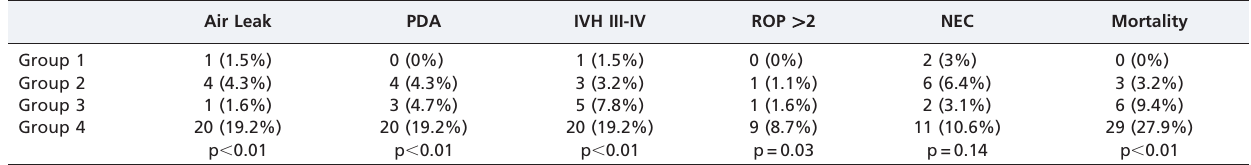
Table 3 - The incidence of adverse outcomes in the different airway-management groups. The need for prolonged mechanical ventilation was associated with significantly higher rates of interstitial emphysema or pneumothorax, PDA, IVH, ROP and